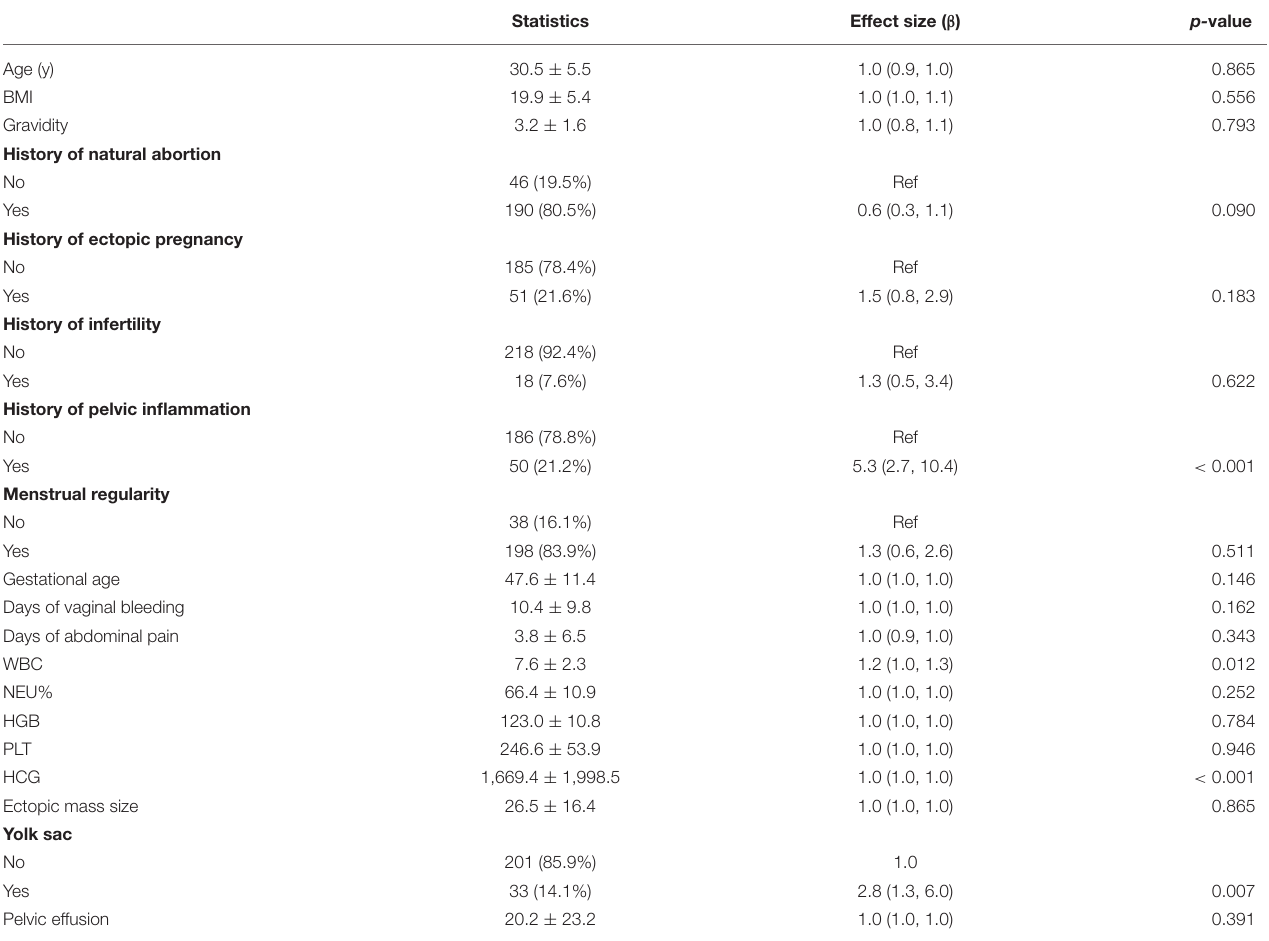
TABLE 2 | Results of univariate